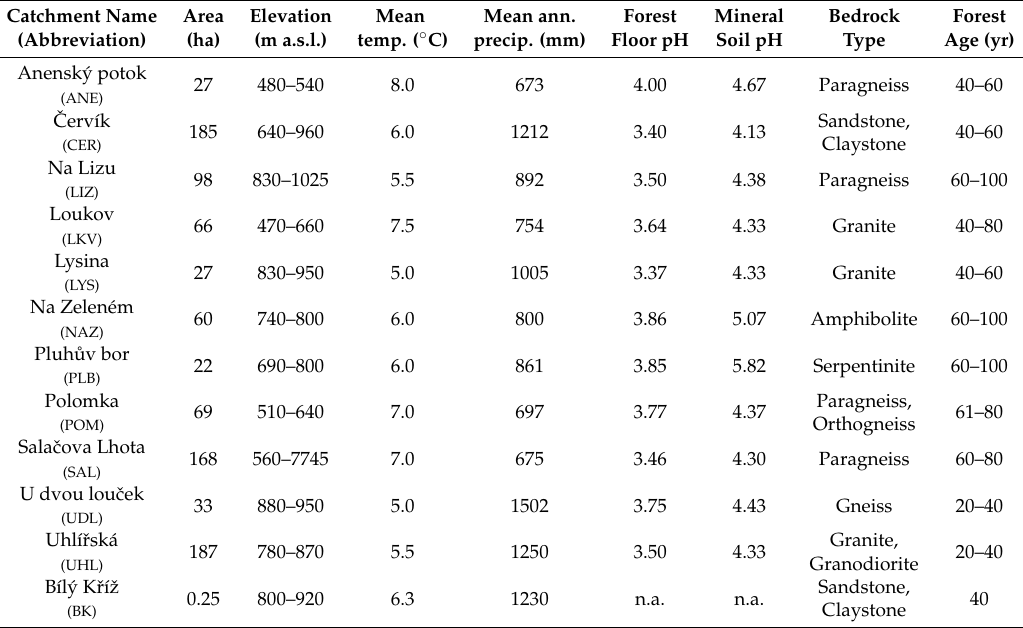
Table 1. Characteristics of small forested stream GEOMON catchments located across the Czech Republic (mean characteristics computed for the period 1994–2016). Last row reports characteristics of an external Bílý Kˇríž site (computed for the period